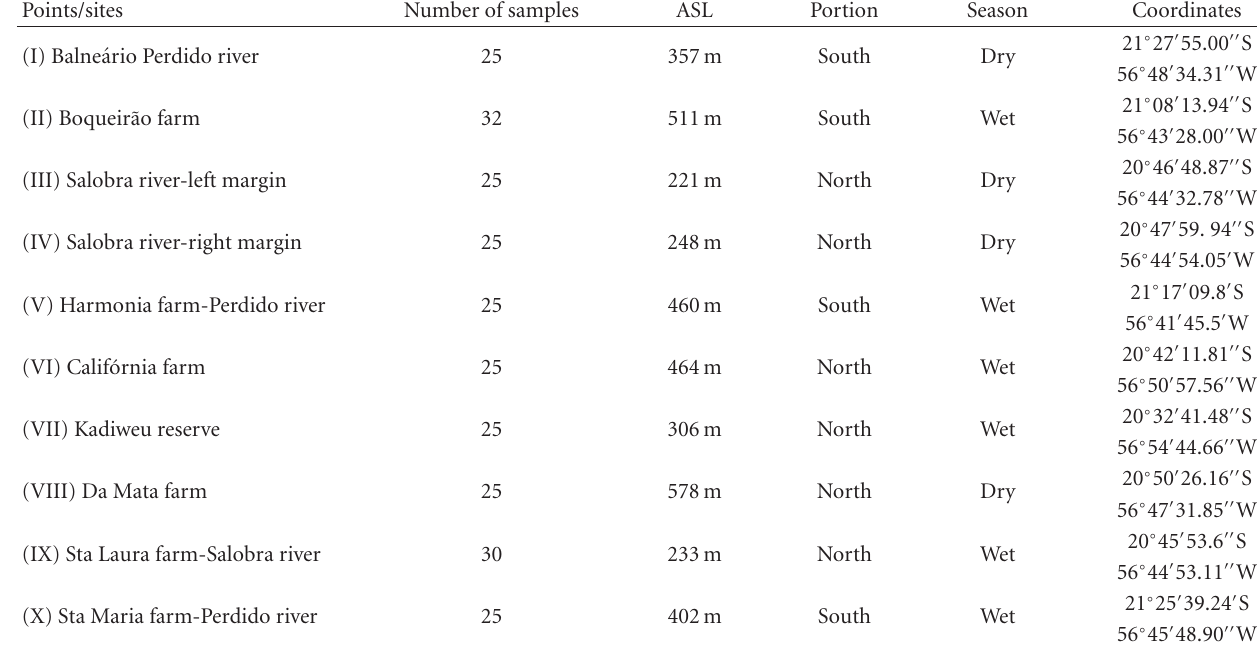
Table 1: Sampling localities, number of samples per site, altitude above sea level, sampling season, and geographic coordinates. Points/sites Number of